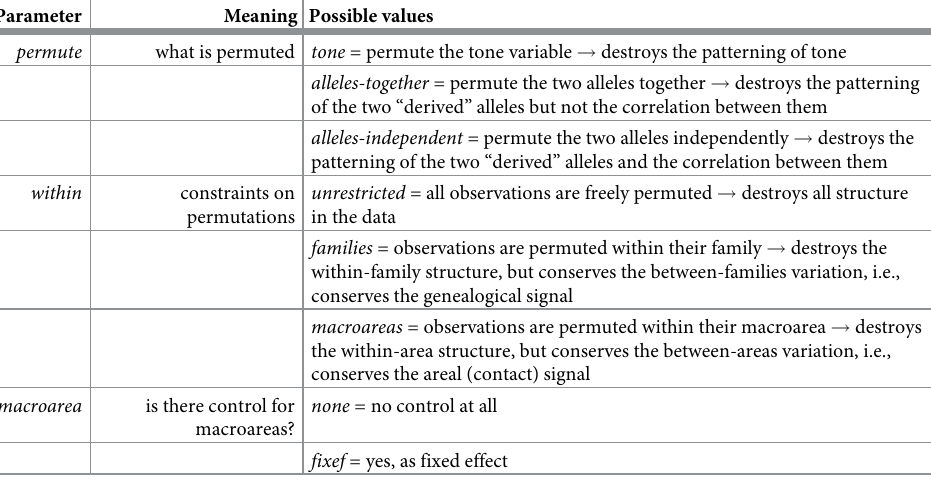
Table 6. The parameters of the randomisation approach, defining, on the one hand, what is permuted and within what constraints, and what to control for in the regression models, on the other.